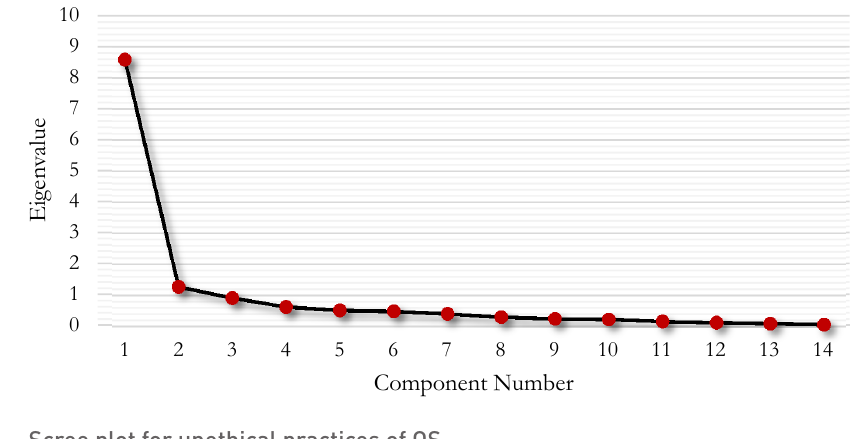
Figure 1. Scree plot for unethical practices of